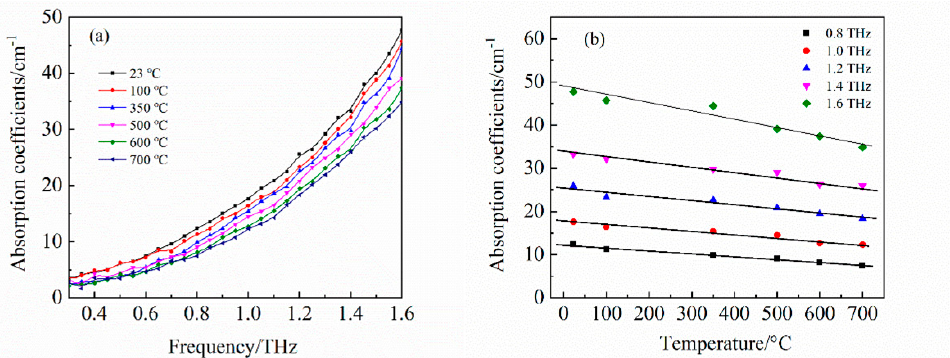
Figure 5. Frequency ‐ dependent absorption coefficients of various calcination temperatures ( a ) and the absorption coefficients fit as a function of temperatures at different frequencies ( b ).